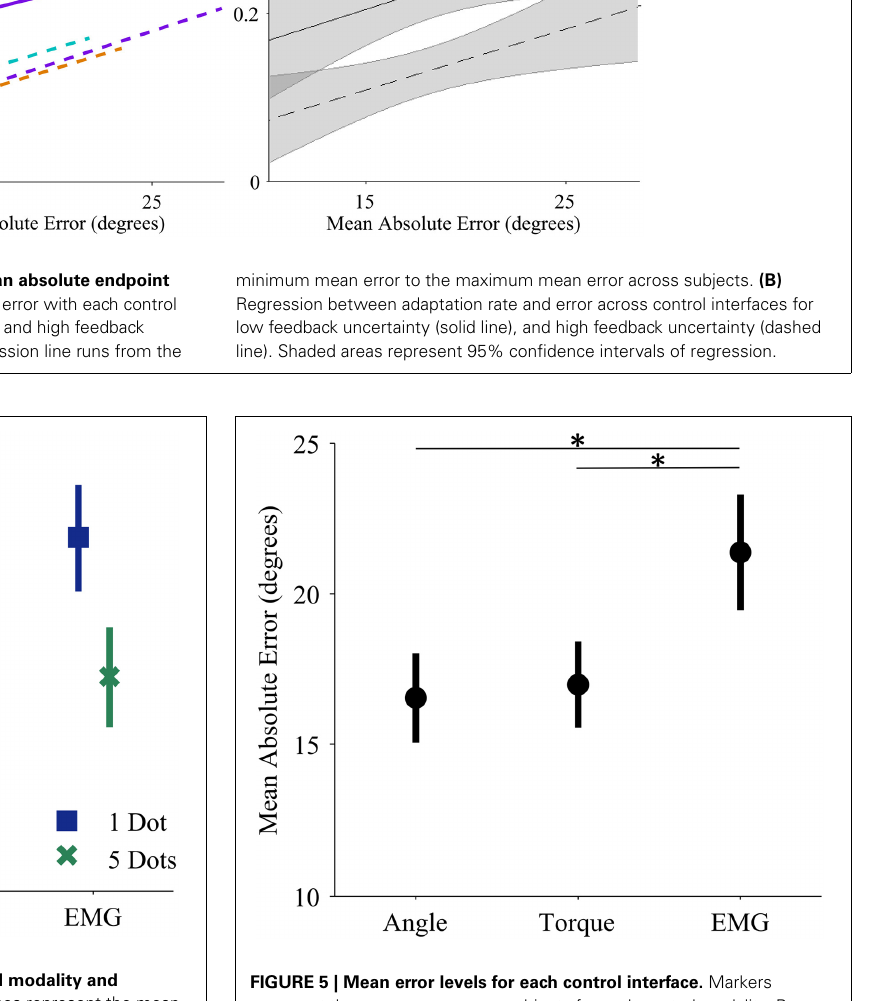
FIGURE 5 | Mean error levels for each control interface. Markers represent the mean error across subjects for each control modality. Bars represent standard errors of the mean. Mean error refers to the mean absolute unperturbed endpoint error of all trials in a single experiment. ( ∗ ) indicates significant difference ( p < 0 . 01) as determined by a One-Way ANOVA with Tukey post-hoc multiple